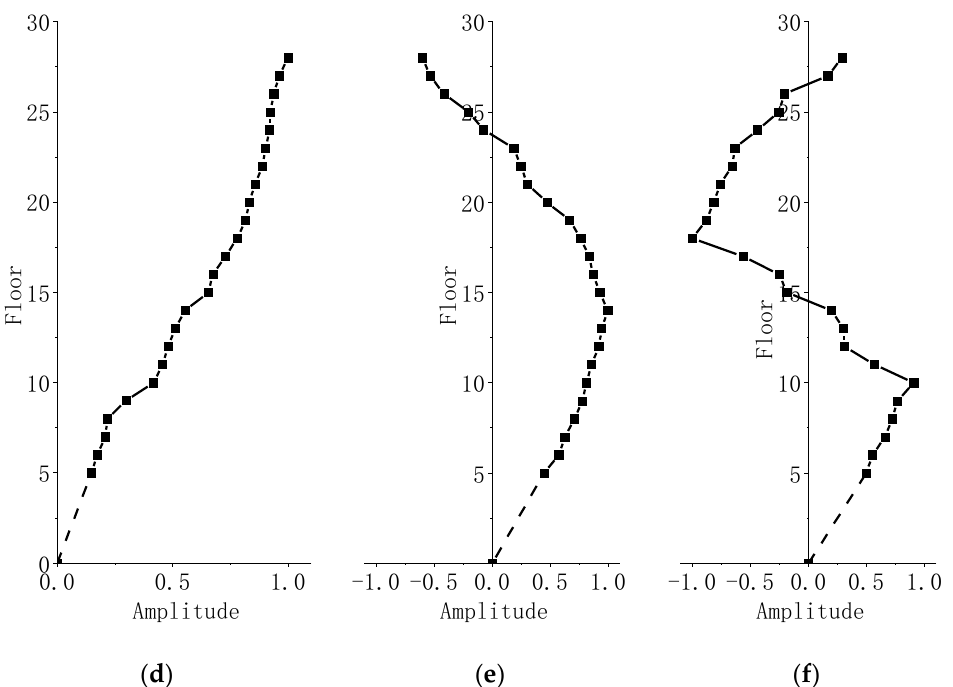
Figure 7. The identified mode shapes of the structure. ( a ) first-order in NS, ( b ) second-order in NS, ( c ) third-order in NS, ( d ) first-order in EW, ( e ) second-order in EW, ( f ) third-order in EW.